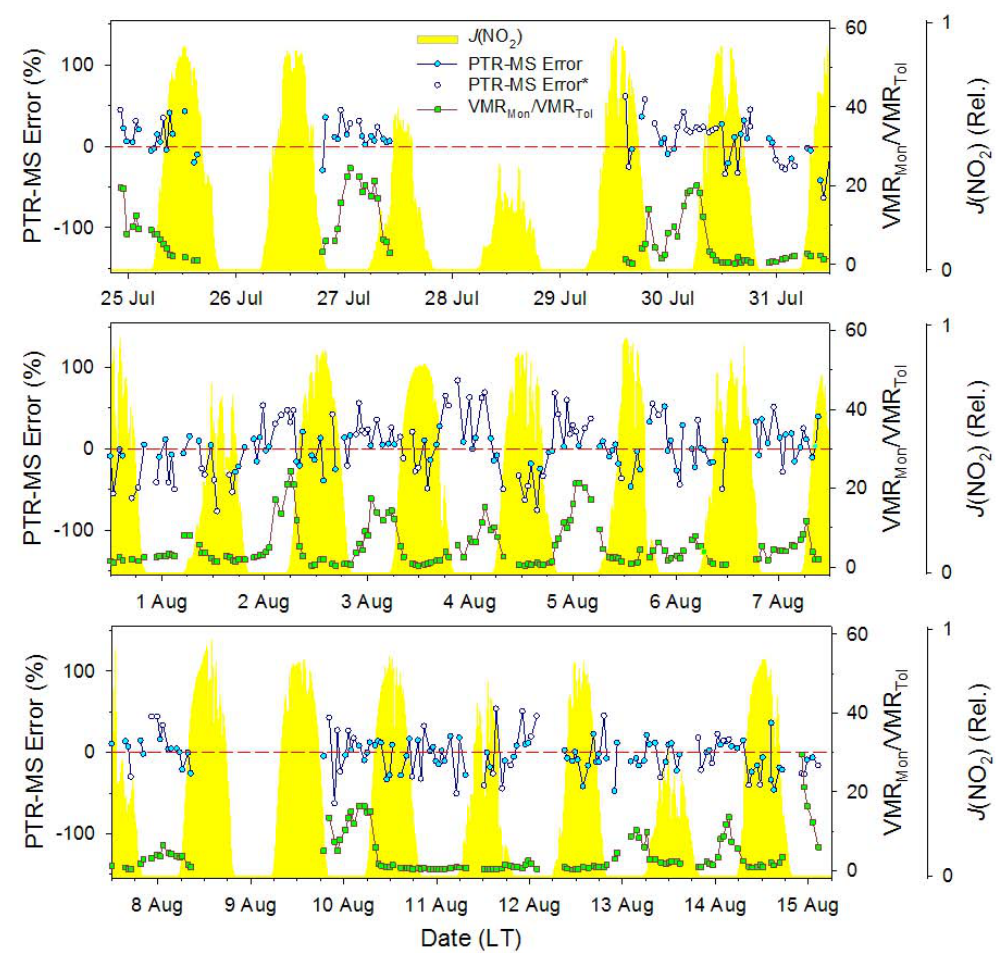
Fig. 8. Comparison between values of ε PTR - MS and 1 Mon for merged GC-FID, PTR-MS data for the period from 24 July, 22:00 LT to 15 August, 06:00 LT. Values of J (NO 2 ) are show as in Fig. 5. *Open symbols correspond with times when the toluene measurements did not agree quantitatively within the combined precisions of the two instruments. The dotted line represents perfect